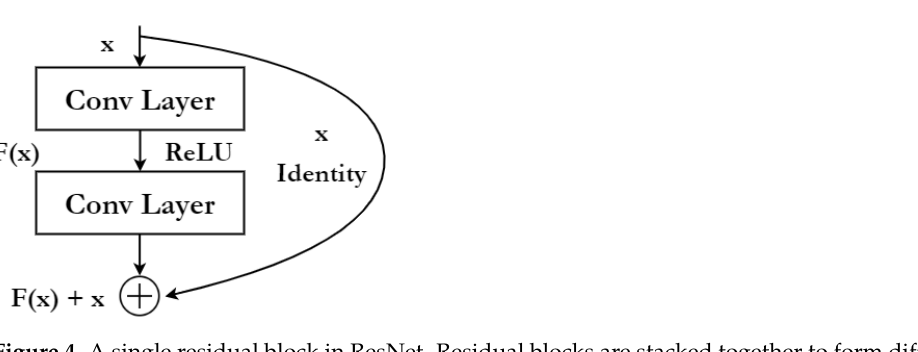
Figure 4. A single residual block in ResNet. Residual blocks are stacked together to form different variants of